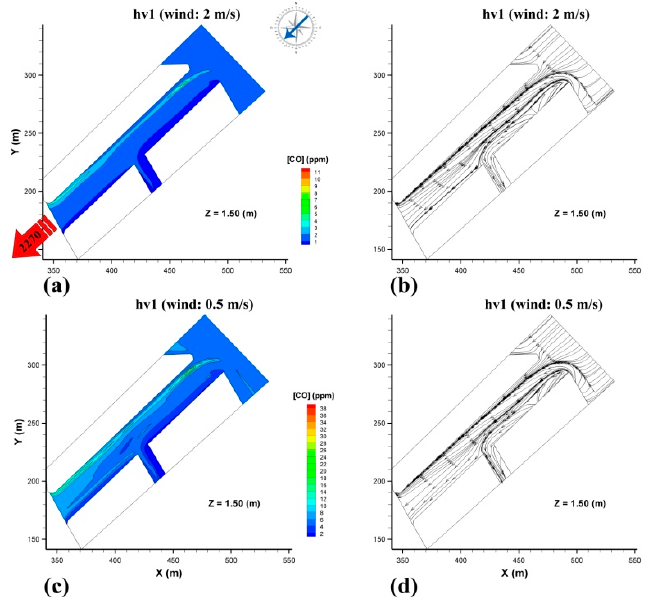
Figure 9. CO concentration contours (ppm) and streamlines in the hypothetical case hv1 for 2 m/s in ( a , b ) and for 0.5 m/s in ( c , d ). Traffic and wind direction are marked with red and blue arrows, respectively.